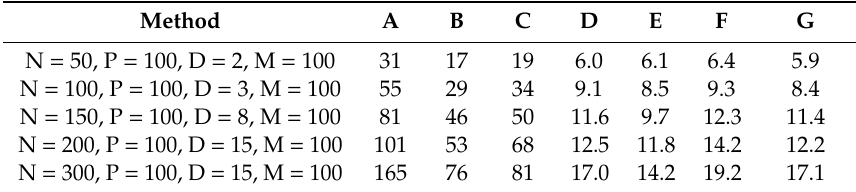
Table 12. Route length comparison of the TSP (Travelling Salesman Problem) algorithms.